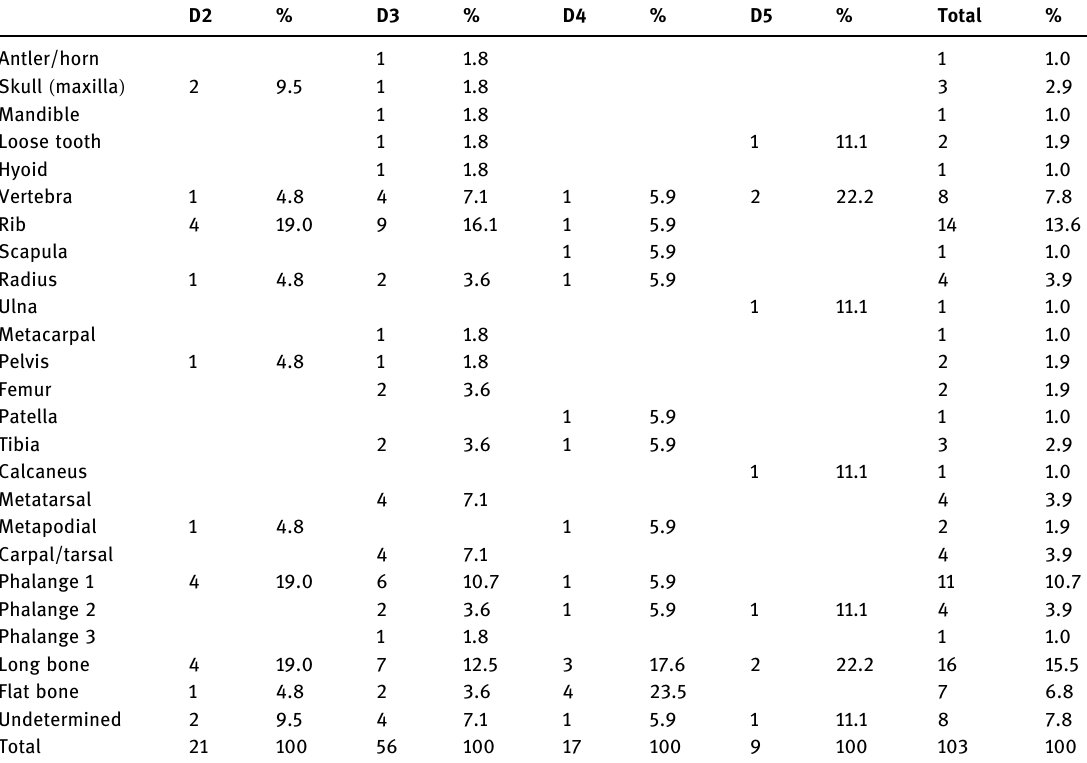
Table 8: Absolute and relative values on the presence of burning damage according to element and degree ( D ) of damage for pit 40 D2 % D3 % D4 Antler/horn